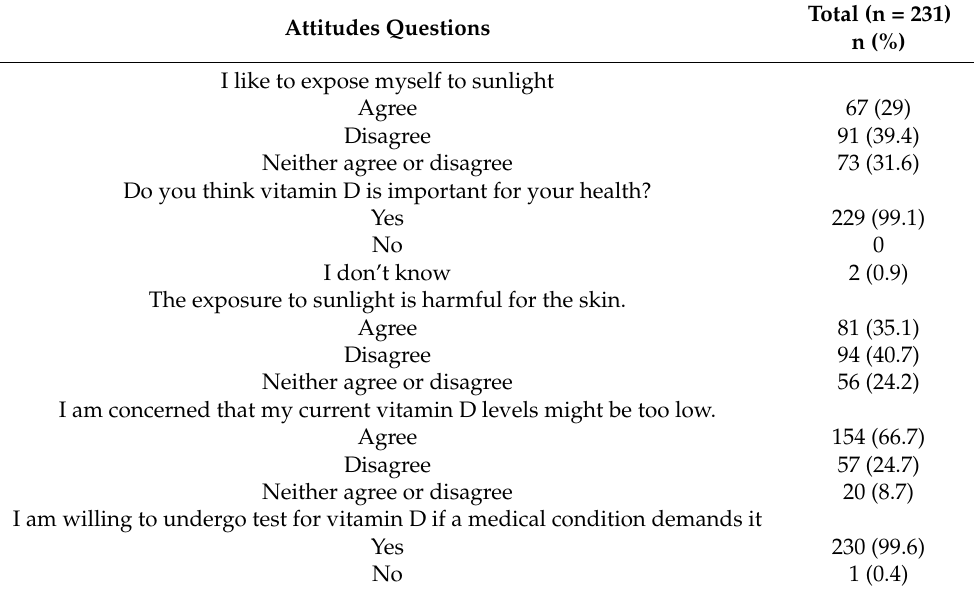
Table 3. Health educator’ attitudes regarding vitamin